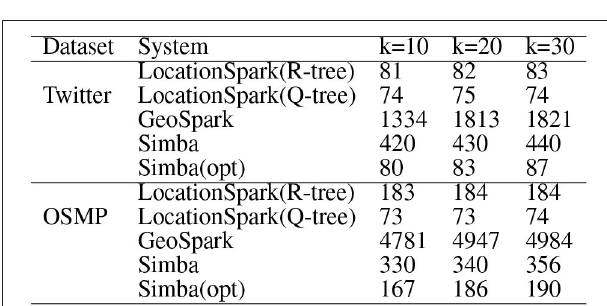
FIGURE 7 | k NN select (in ms).